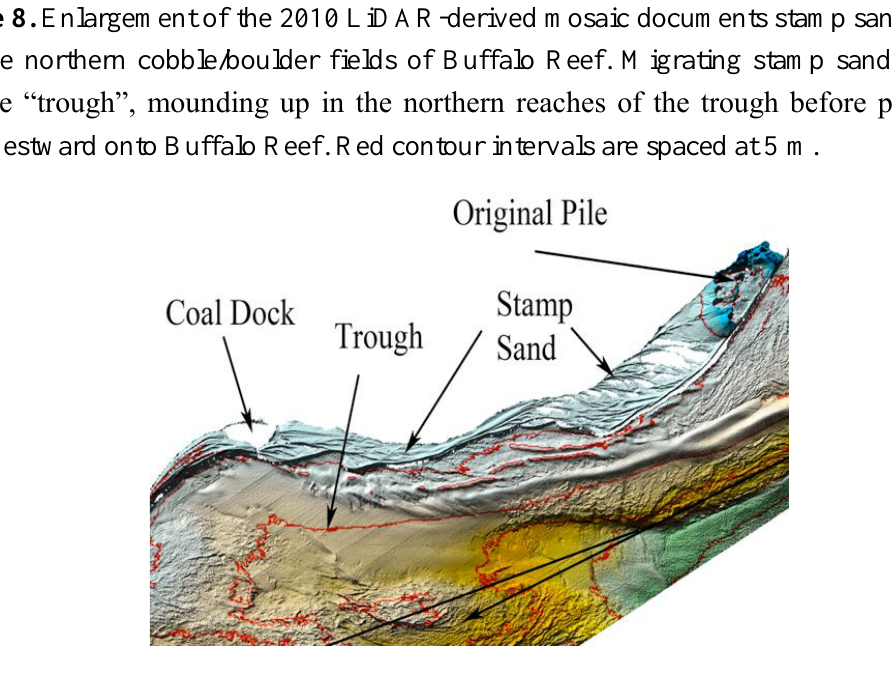
Figure 9. MSS-derived coastal substrate map, based on bottom color reflectance. Dots indicate Ponar and underwater camera ground-truth checks of substrate types (modified from Kerfoot et al. [3]). The boundaries of Buffalo Reef are superimposed upon the substrate map. Red regions indicate low reflectance areas where migrating stamp sands have encroached upon Buffalo Reef cobble and boulder